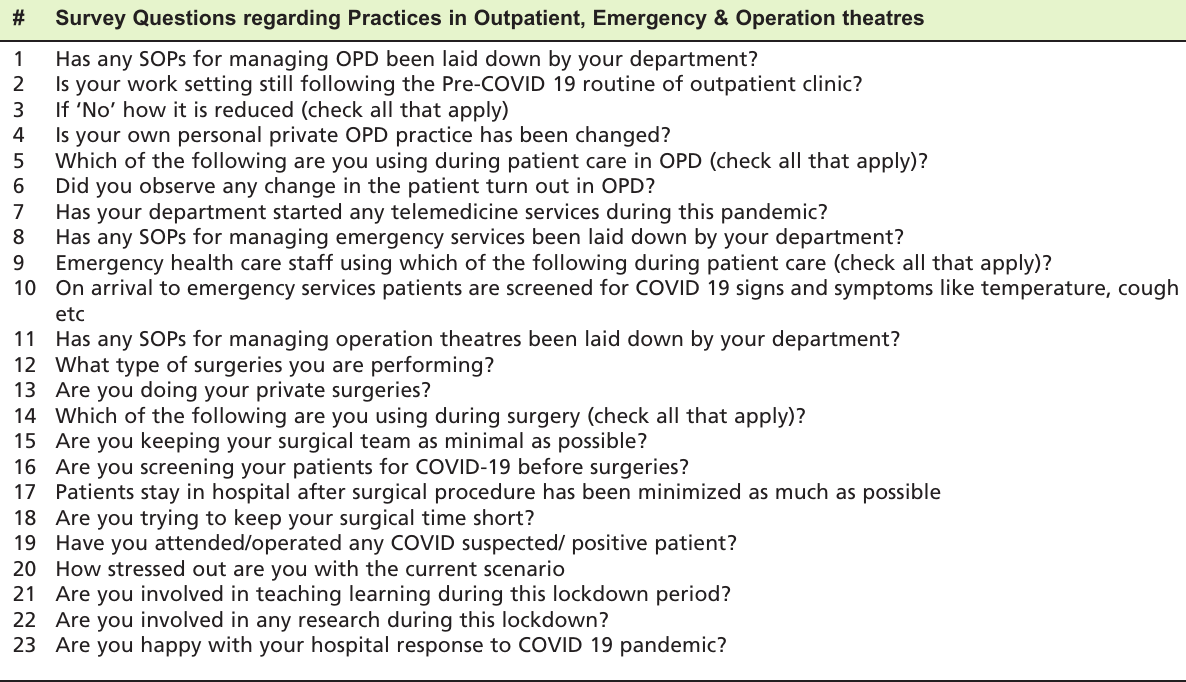
Table showing survey questions that were asked from the participants regarding their practice Table I: